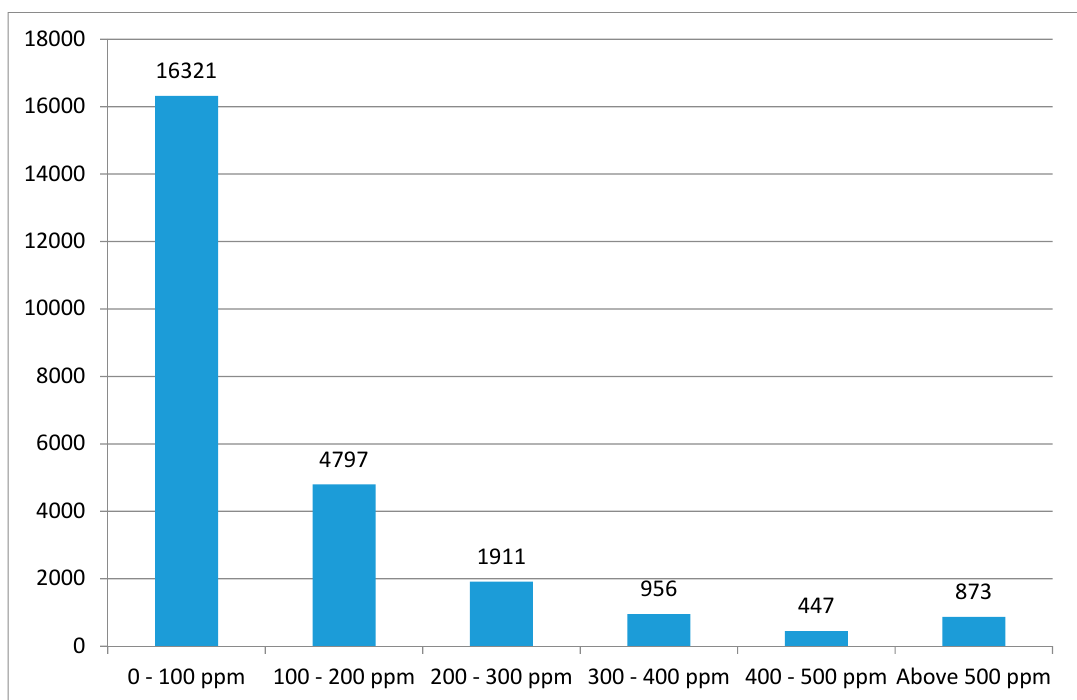
Figure 2. Distribution of soil Pb concentration (ppm or mg/kg).